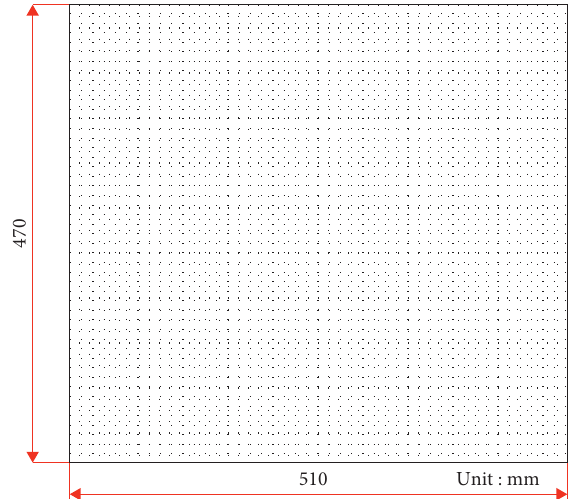
Figure 3: Mesh setup of a two-dimensional rectangular tank (unit: